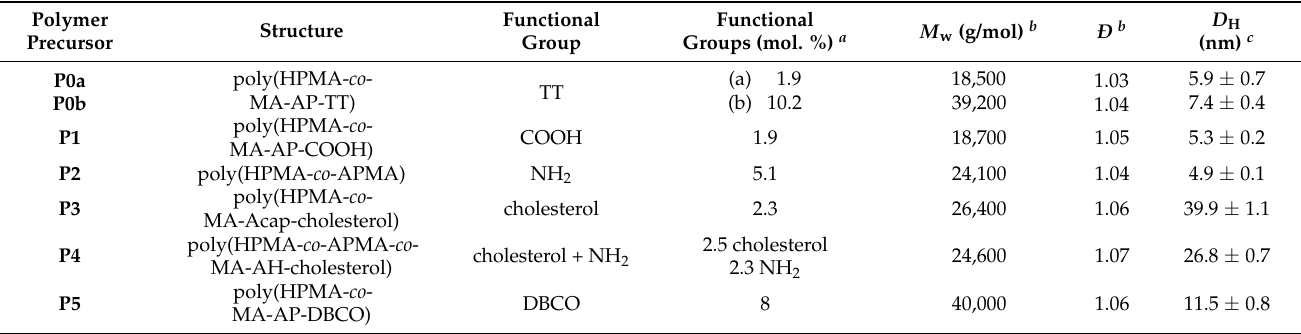
Figure 2. Polymer precursors and Mo 6 clusters used for non-covalent and covalent interactions: ( A ) chemical structures of precursors P1 – P5 ; ( B ) schematic representation of the molecular structure of [M 6 L i 8 L a 6 ] n cluster and ligands for clusters C1–C4 ; color coding: molybdenum (blue), iodine (L i : magenta), apical ligands (L a : green); hydrogen atoms are omitted for clarity. Table 1. Physico-chemical characteristics of the polymer